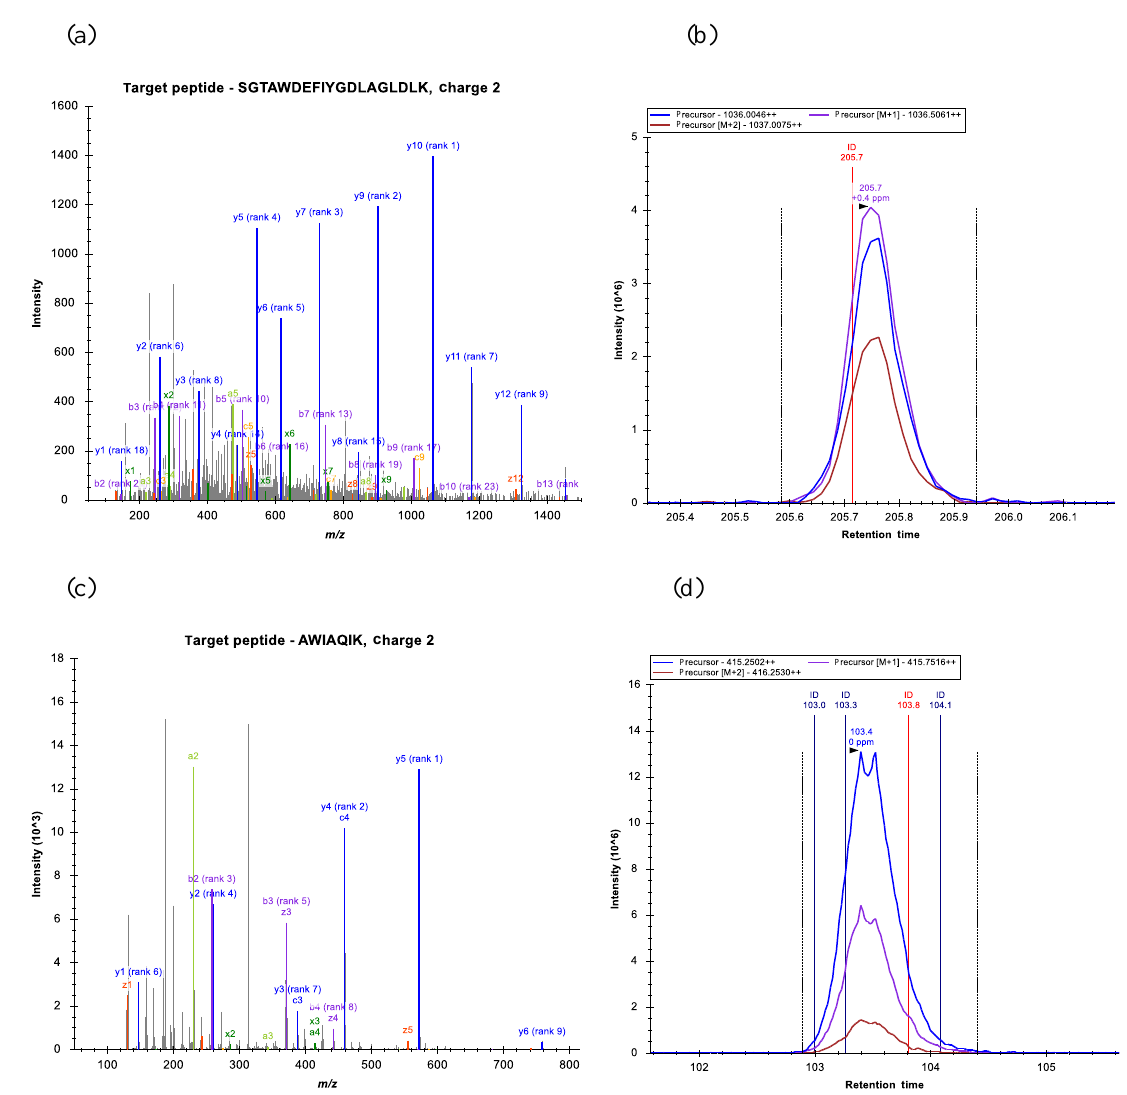
Figure 11. Example spectra and chromatograms of fragment ions for two peptides corresponding to a P. antarctica flavodoxin iden- tified from the Ross Sea metaproteome sample (peptide sequences found within Database 1, 1871, contig_31444_1_606_ + , 1374, contig_202625_47_661_ + ; Database 2, contig_175060_39_653_ + ). Peptide fragmentation spectra are shown in (a) and (c) and example chromatograms of MS1 intensities as well as with + 1 and + 2 mass addition for isotopic distributions are shown (b) and (d) , demonstrating the utility of these iron stress biomarkers in field